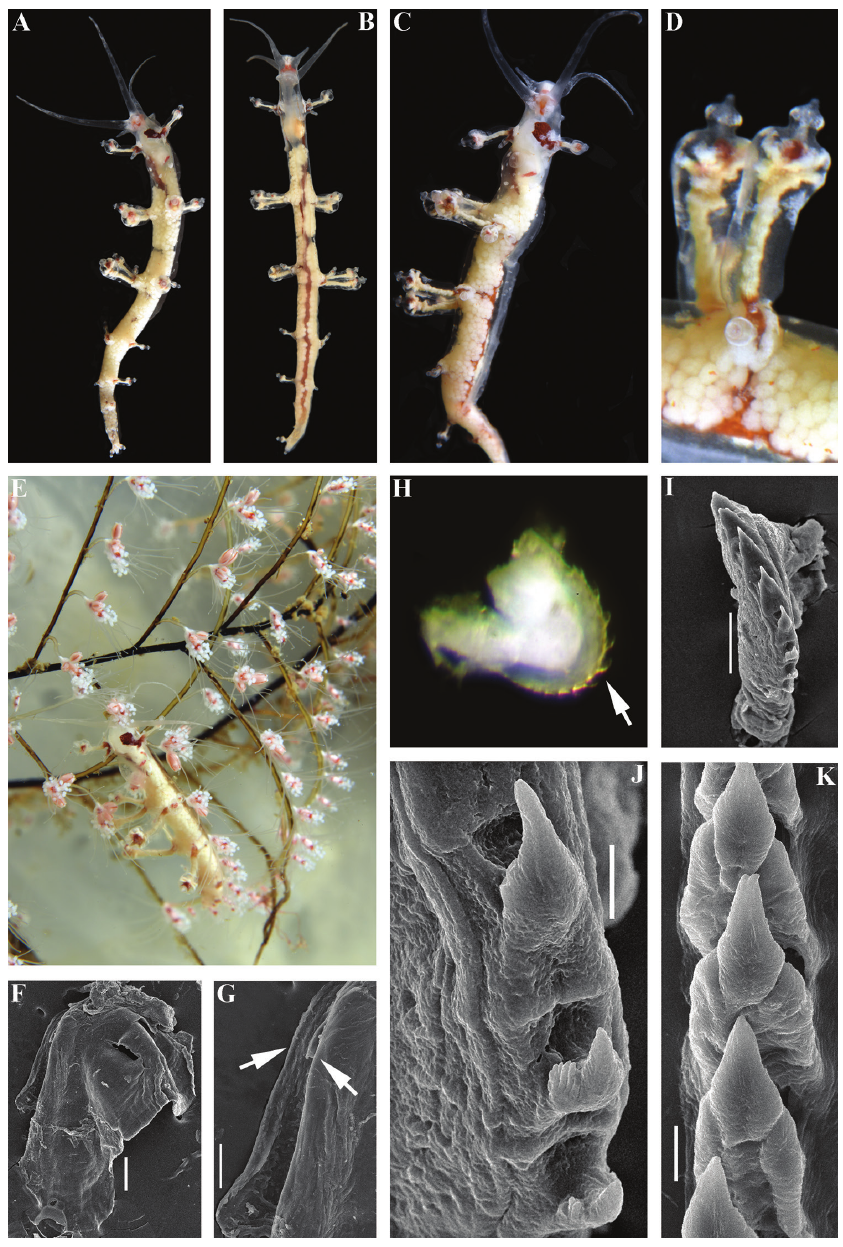
Figure 3. Myja hyotan sp. n., holotype. A dorsal view B ventral view C lateral view D details of cerata E dorsal view on hydroids in situ F jaw G smooth masticatory processes of jaws (indicated by arrows), SEM H radula on odontophore, to show reduced anteriormost teeth (arrow), LM I anterior teeth with strongly reduced anteriormost teeth, SEM J teeth from the middle part of radula K posterior part of radula to show smooth teeth. Scale bars: 100 μm ( F ); 50 μm ( G, I ); 10 μm ( J, K ). Photographs of living specimens by TA Korshunova and AV Martynov, SEM images by AV